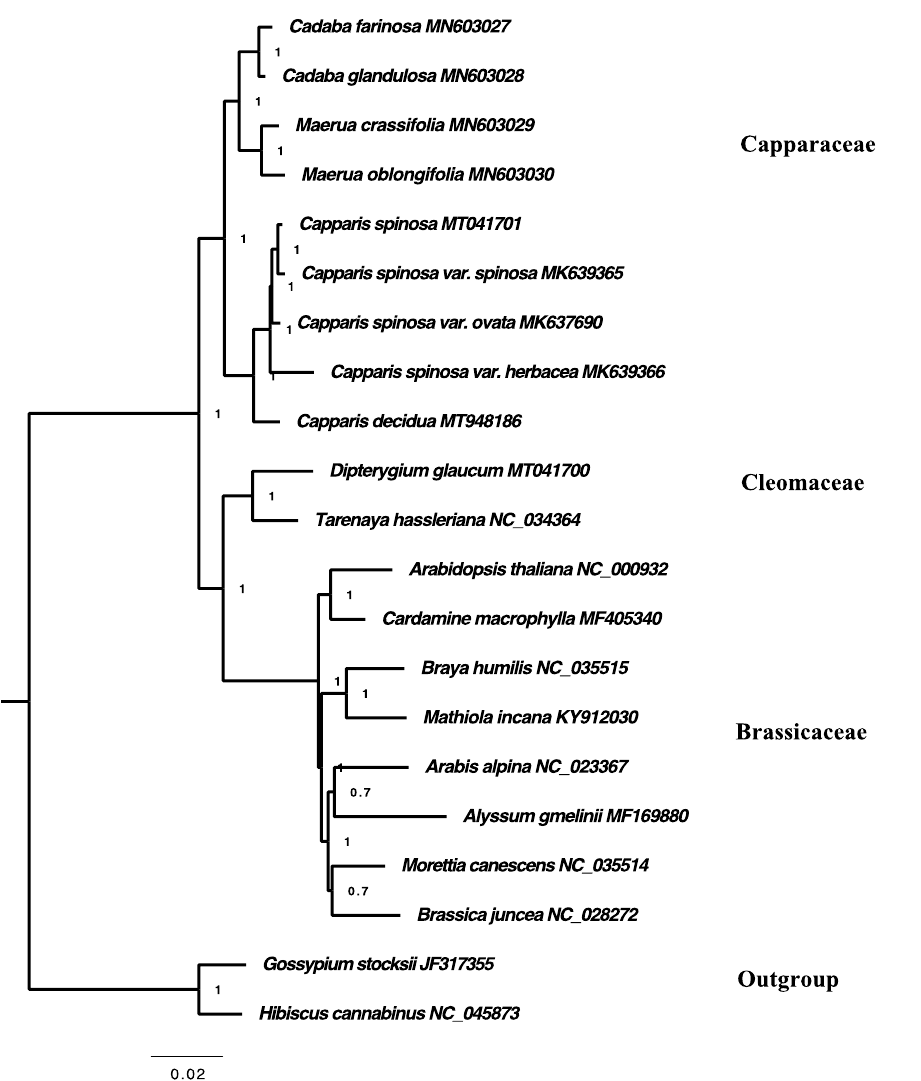
Figure 9. Phylogenetic tree reconstruction based on the complete chloroplast genome of 21 taxa inferred from Bayesian inference (BI) methods, showing relationships within Brassicales. Numbers in the clade represent posterior probability (PP) values.